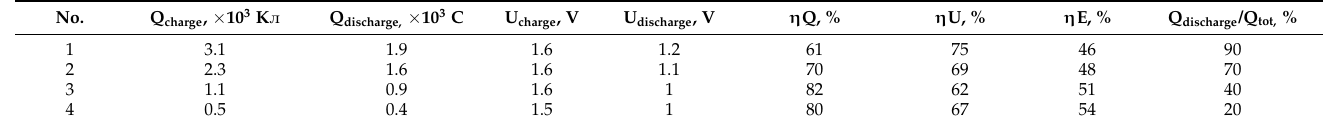
Table 1. Characteristics of the charge—discharge cycle of a hydrogen-bromate flow battery according to Figure 6.